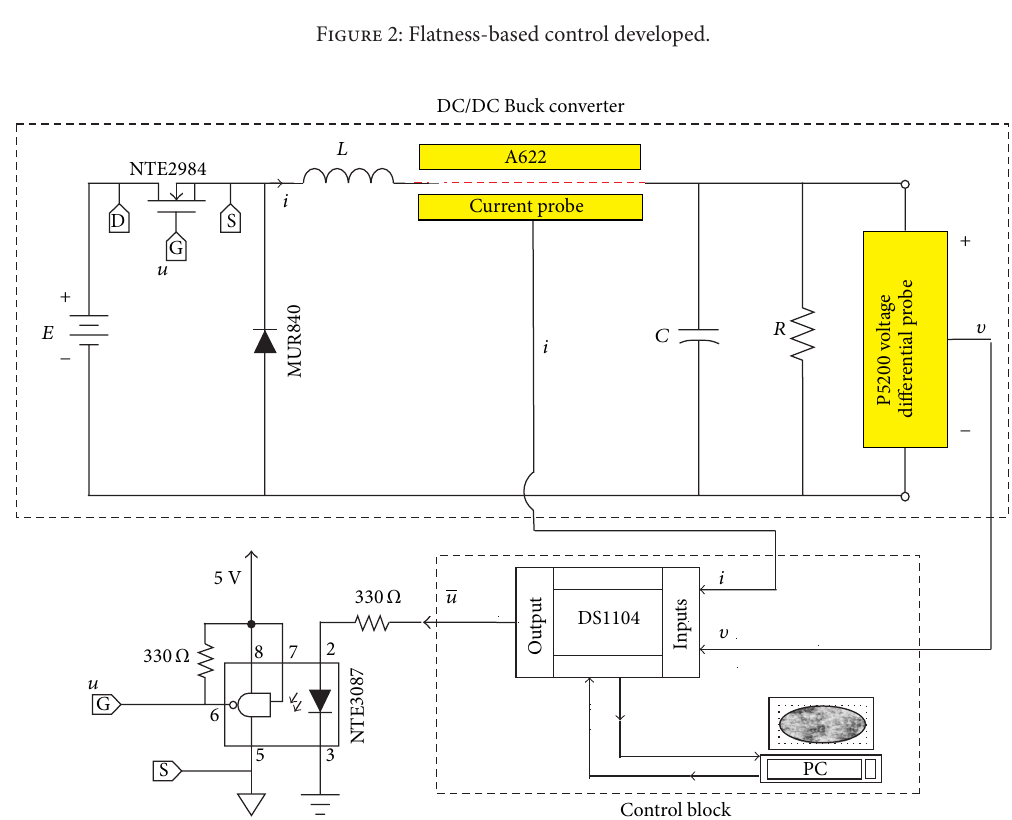
Figure 3: Connection diagram used for the